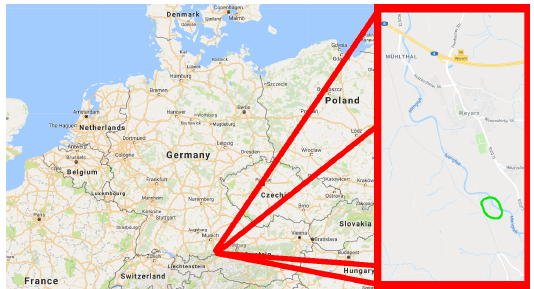
Figure 4. The Mangfall area, in the background: the map of Germany from Google maps, in the marked area: green marked area: the testing side located in the Mangfall area.